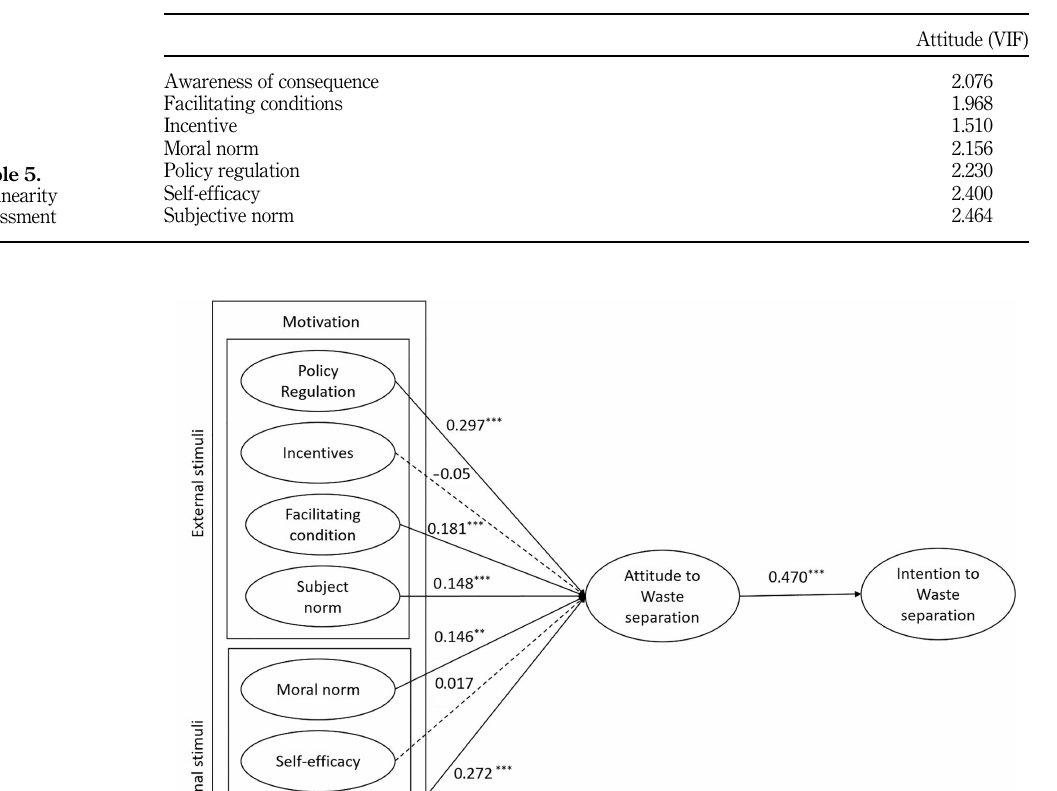
Figure 2. Results